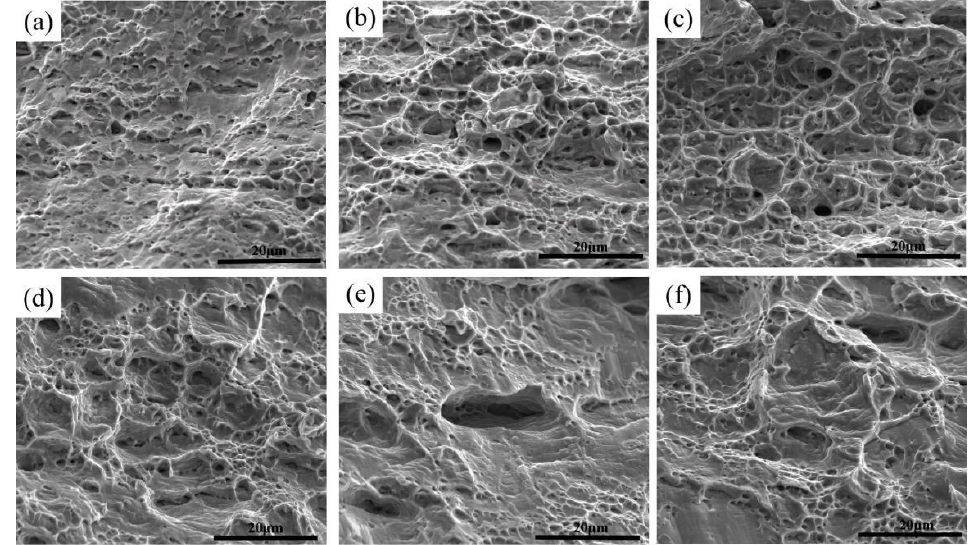
Figure 15. SEM images of the fracture surface: ( a ) 650 °C/15 min; ( b ) 650 °C/30 min; ( c ) 650 °C/60 min; ( d ) 770 °C/15 min; ( e ) 770 °C/30 min; ( f ) 770 °C/60 min. ( d ) 770 ◦ C / 15 min; ( e ) 770 ◦ C / 30 min; ( f ) 770 ◦ C / 60